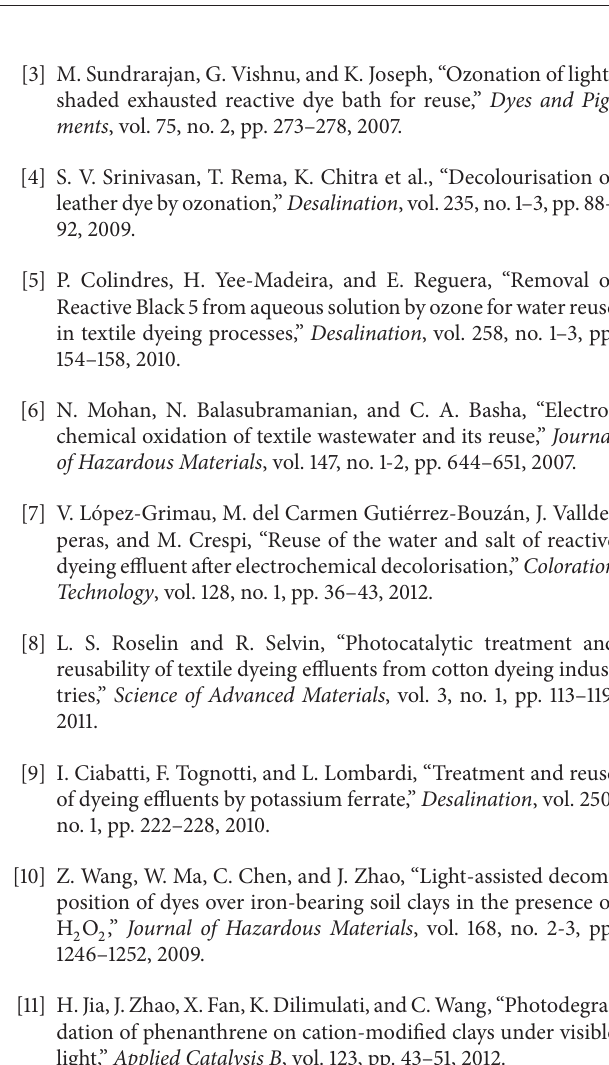
shaded exhausted reactive dye bath for reuse,” Dyes and